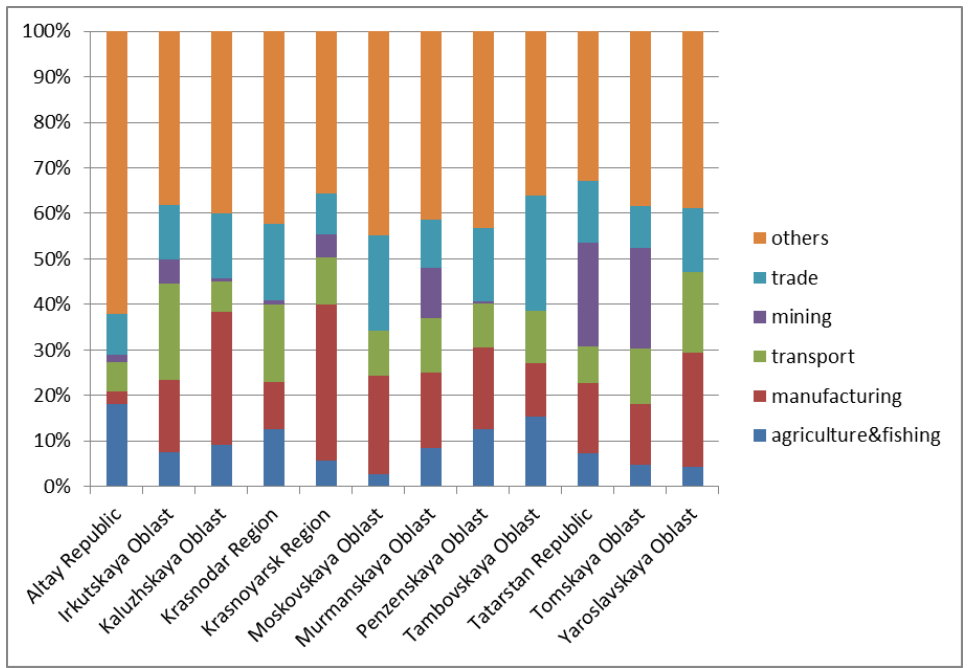
Figure 4: The share of main industries in regional GDP for chosen regions (2009) Source: Author own